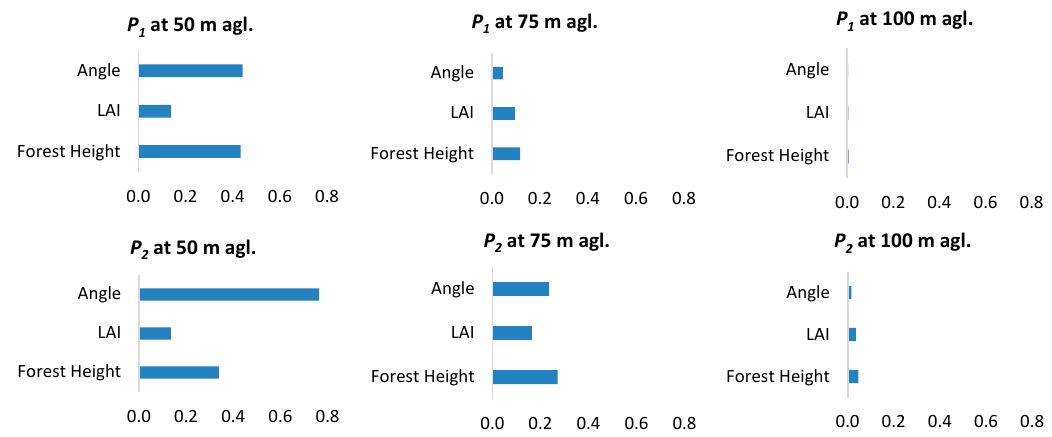
ff ects for the turbulent kinetic energy at di ff erent altitudes on L Figure 8. Pareto chart of effects for the turbulent kinetic energy at different altitudes on 𝐿 1 and 𝐿 2 . Figure 8. Pareto chart of e